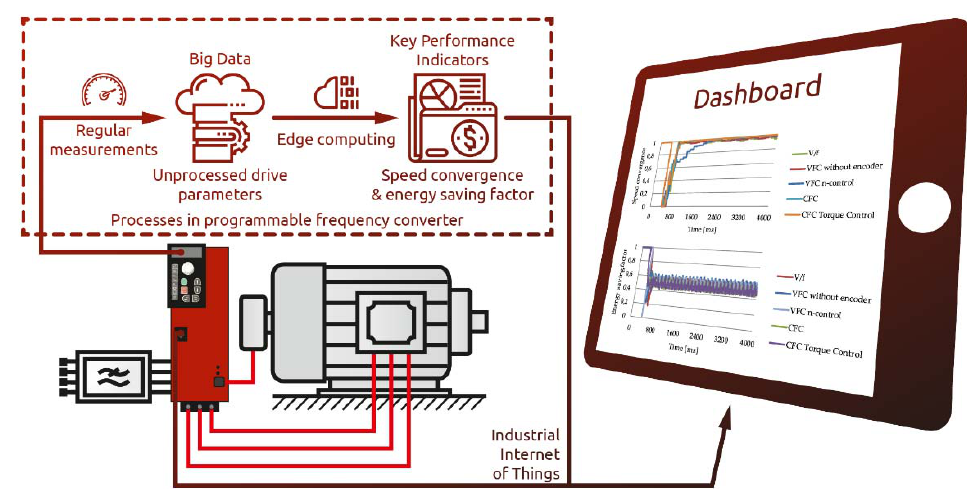
Figure 12. Concept of the system where the elaborated edge computations are used in drive management with IIoT de- vices.